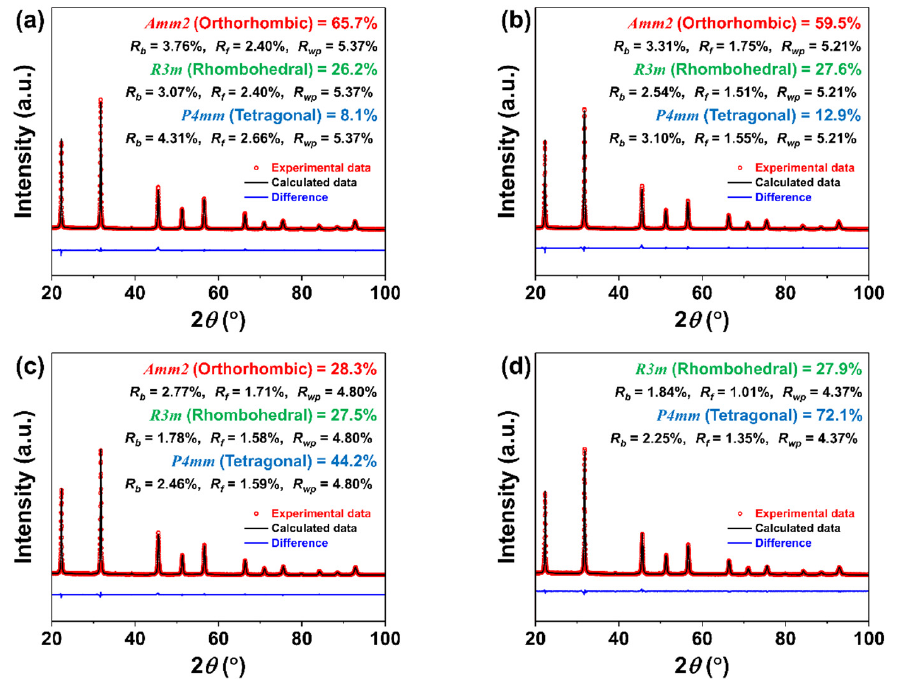
Figure 6. Rietveld refinement of the XRD patterns obtained for the textured NKNS-(0.04 − x)SZ-xBAZ thick films with ( a ) x = 0.0, ( b ) x = 0.01, ( c ) x = 0.03, and ( d ) x = 0.04. Table 2. Parameters calculated from Rietveld refinement of the XRD data of the textured NKNS ‐